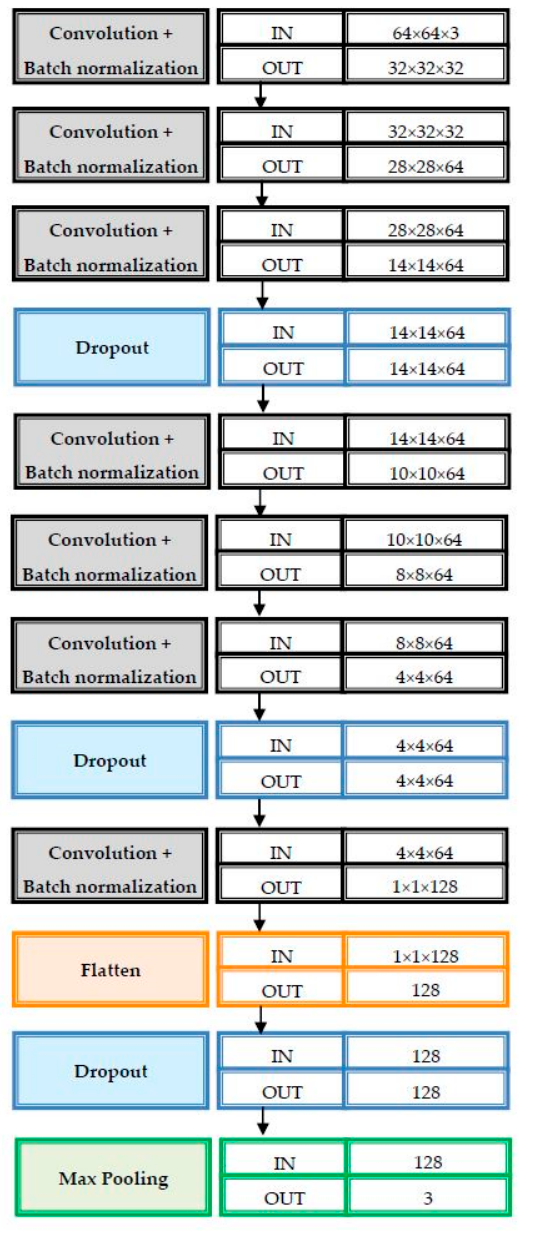
Figure 8. AlexNet architecture.